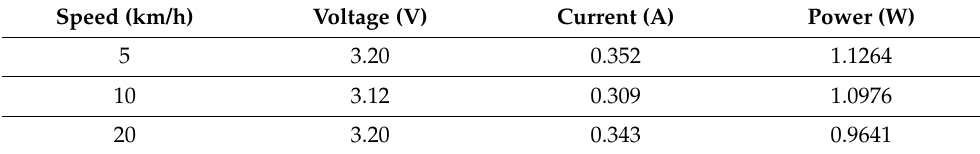
Table 6. Electrical quantities of the power-generating floor under different driving speeds. Speed (km/h) Voltage (V) Current (A) Power